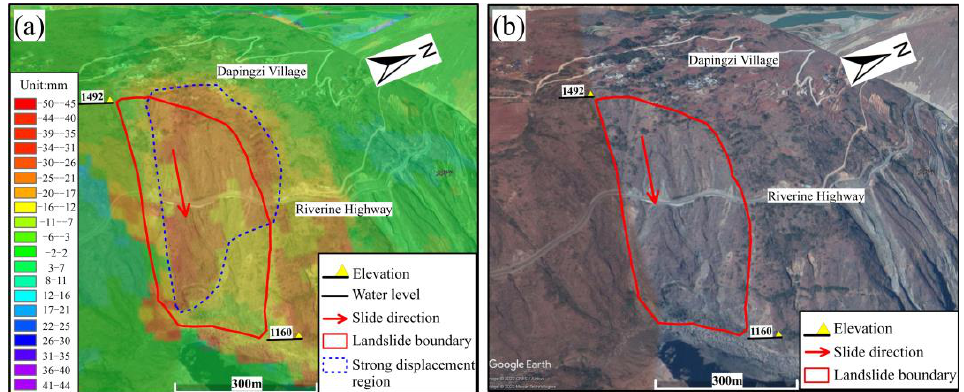
Figure 10. ( a ) The MLP neural network atmosphere corrects the displacement results; ( b ) remote interpretation of displacement.